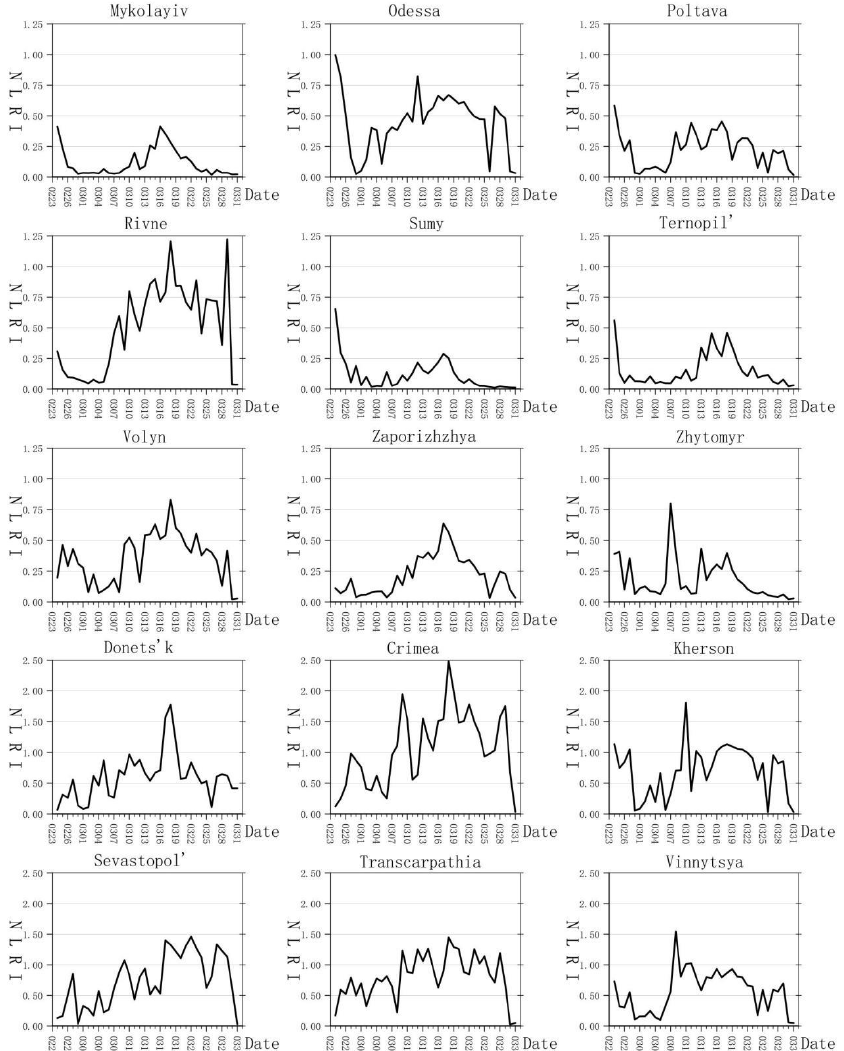
Figure 5. Schemes follow the same formatting.